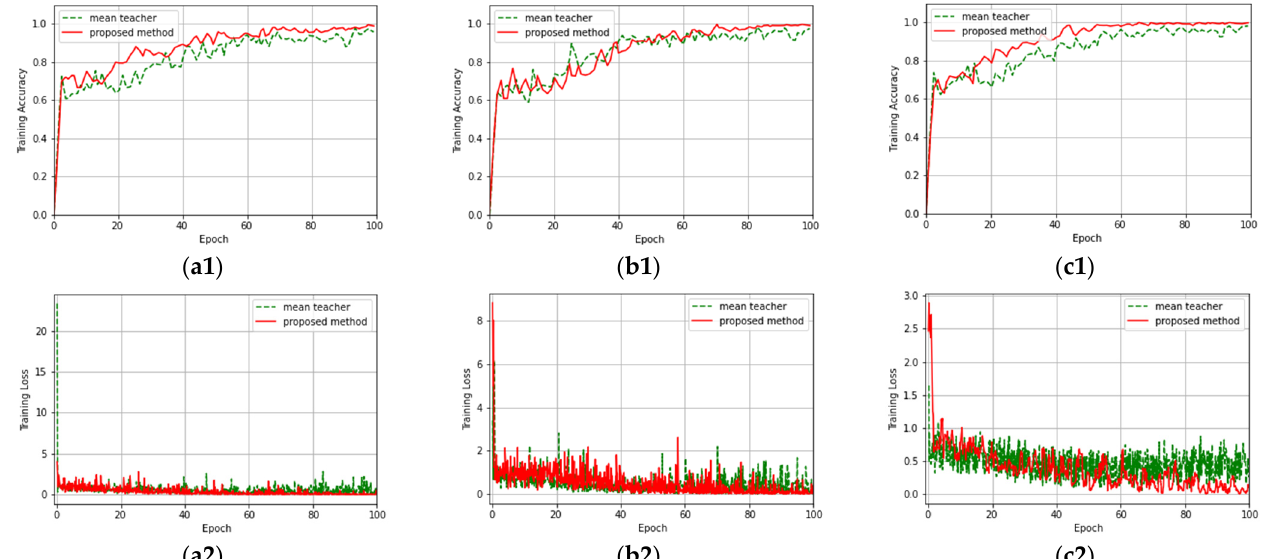
Figure 9. Training accuracy (top row) and loss (bottom row) comparison of mean teacher and the proposed method under three percentages of labeled data: ( a1 , a2 ) ε = 10%; ( b1 , b2 ) ε = 20%; ( c1 , c2 ) ε = 50%.